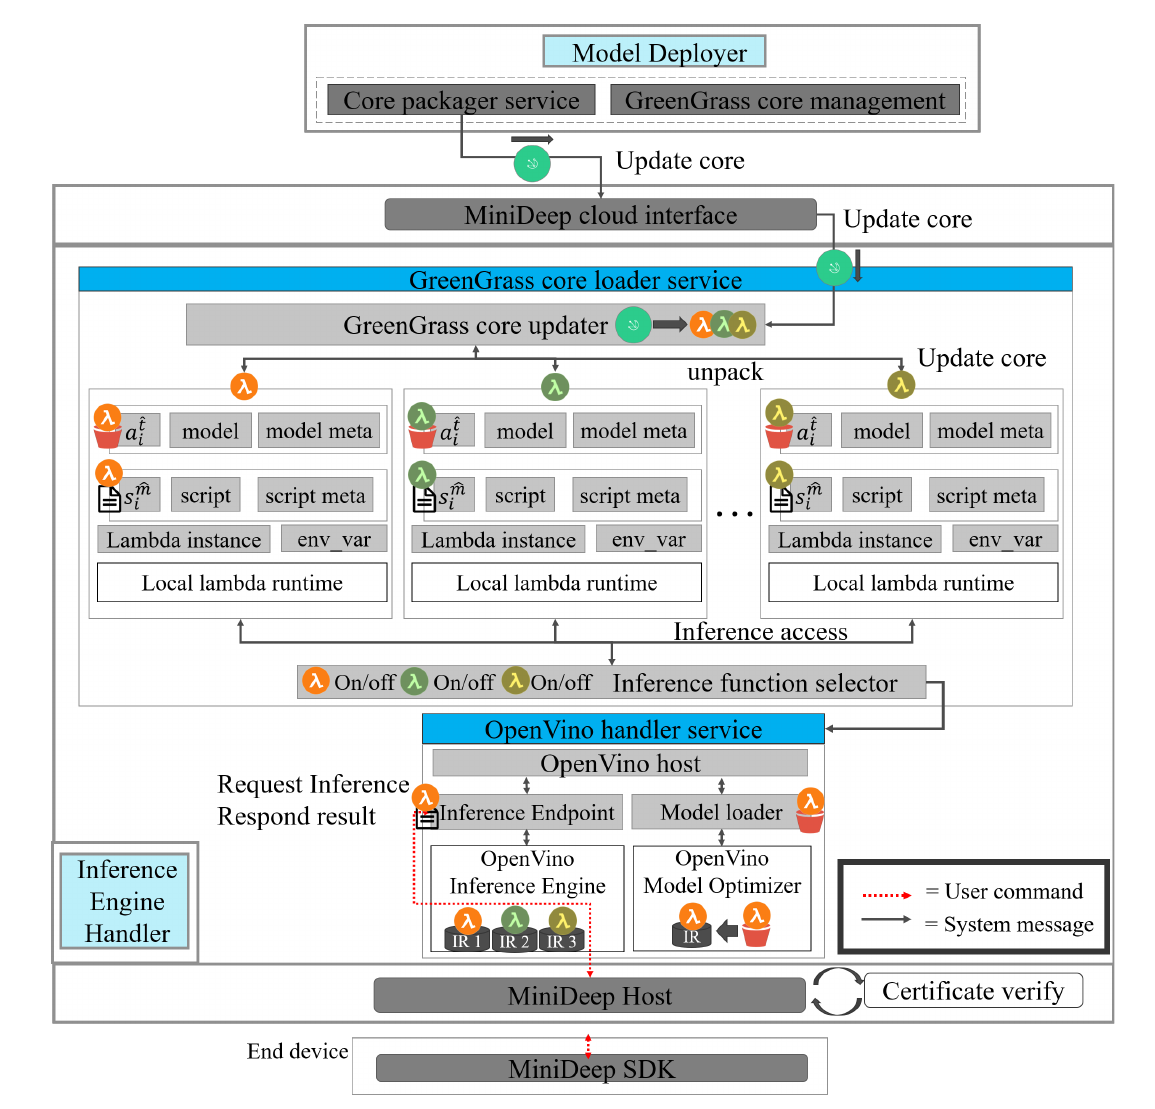
Figure 7. The detailed function of the inference engine